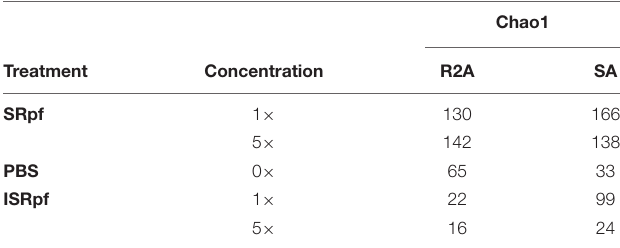
TABLE 1 | Chao1 estimator for each treatment, concentration, and agar type (SA and R2A).